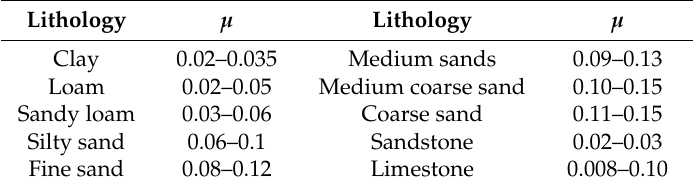
Table 2. The empirical values of specific yield for different